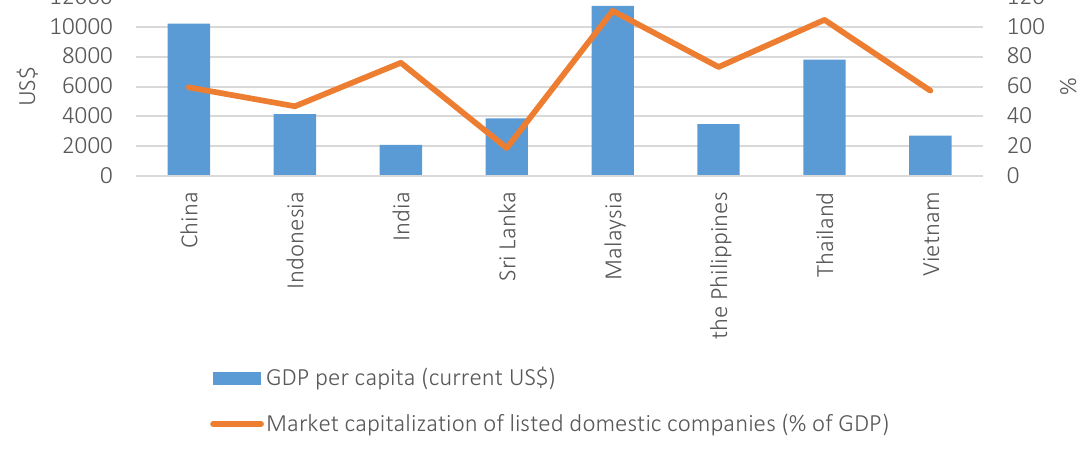
Figure 1. GDP per capita and SMD of Asian EMDEs in Table 5. Model testing results